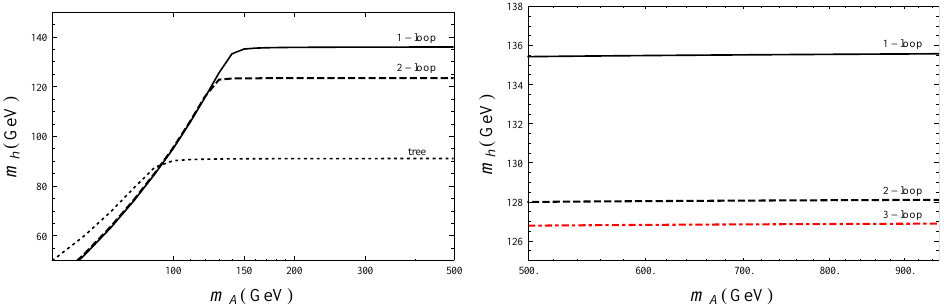
Figure 3. ( Left ) Predictions of the lightest Higgs boson mass, m h , at tree (dotted), one-loop (solid), and two-loop (dashed) levels as a function of the CP-odd Higgs boson mass m A . We have considered the m max scenario ( X t ≈ 2.4 M SUSY ) at the kinematical point tan β = 30, M SUSY = 1 TeV, µ = 200 GeV h and with a gluino mass M ˜ g = 1.5 TeV. ( Right ) The three-loop m h -predictions (dot-dashed red line) are included for large m A in the maximal stop mixing scenario.